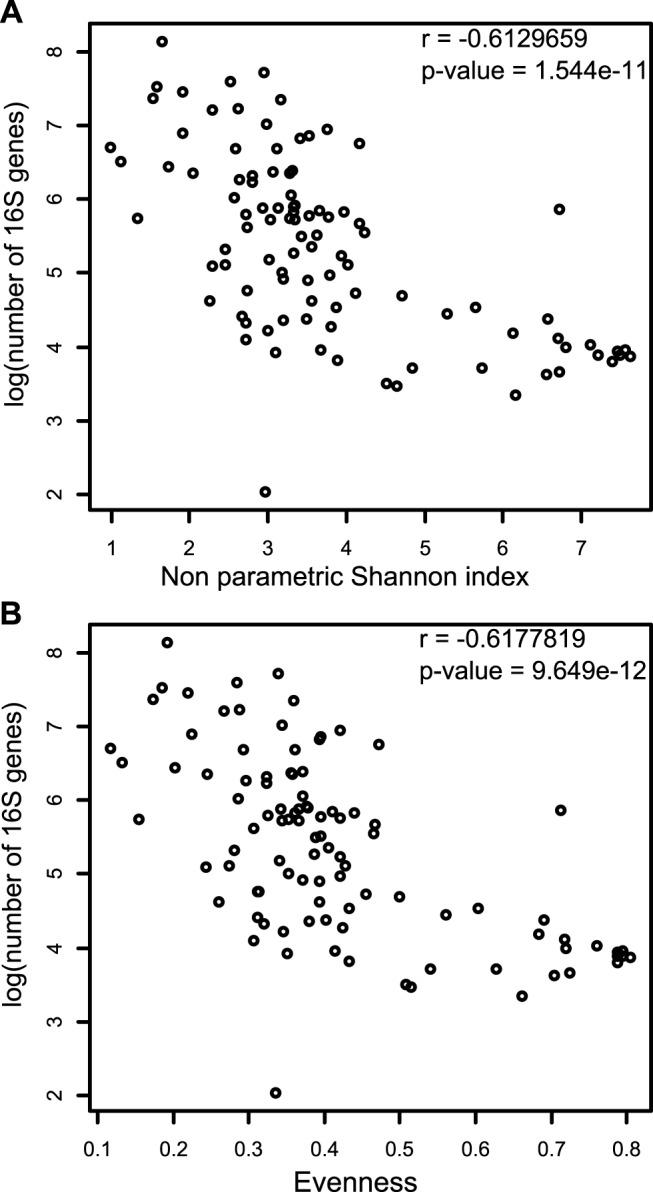
Correlation between alpha-diversity and bacterial load in CF airways.The alpha-diversity is represented by the non parametric Shannon index (A) and the evenness index based on the Shannon index (B). The microbial load was measured via the proxy of the number of 16S genes. Samples from the three sampling sites are represented.